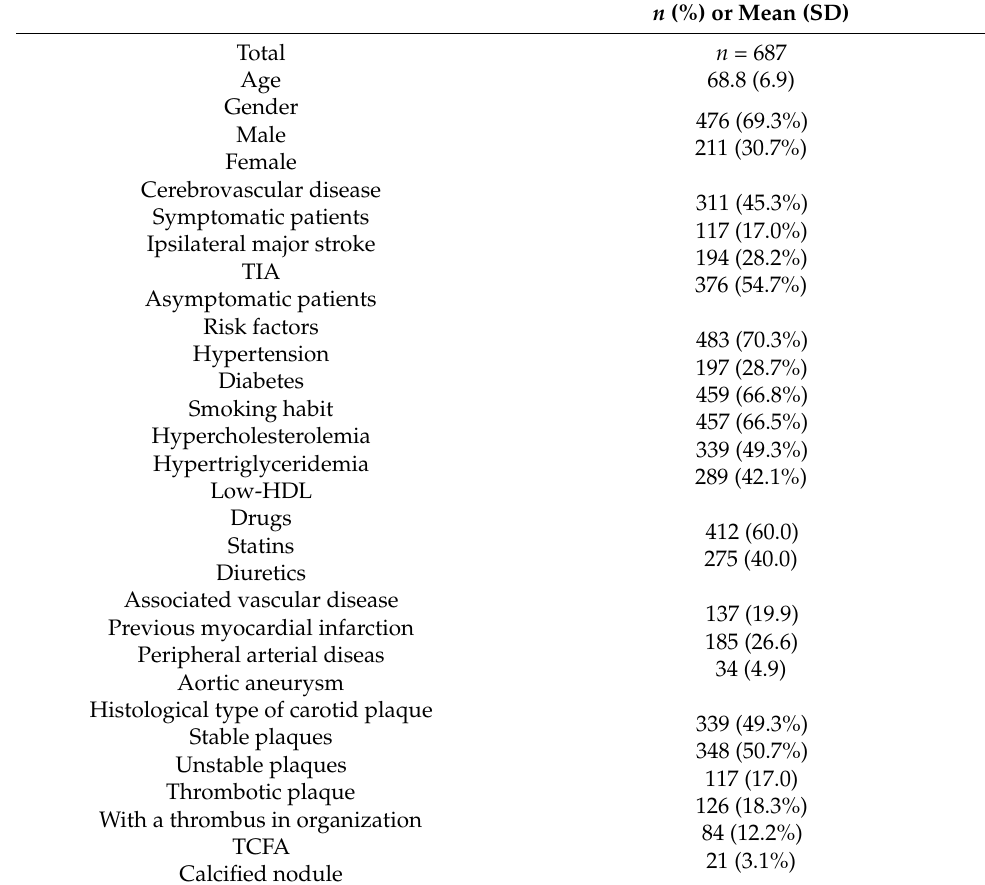
Table 1. Baseline characteristics of